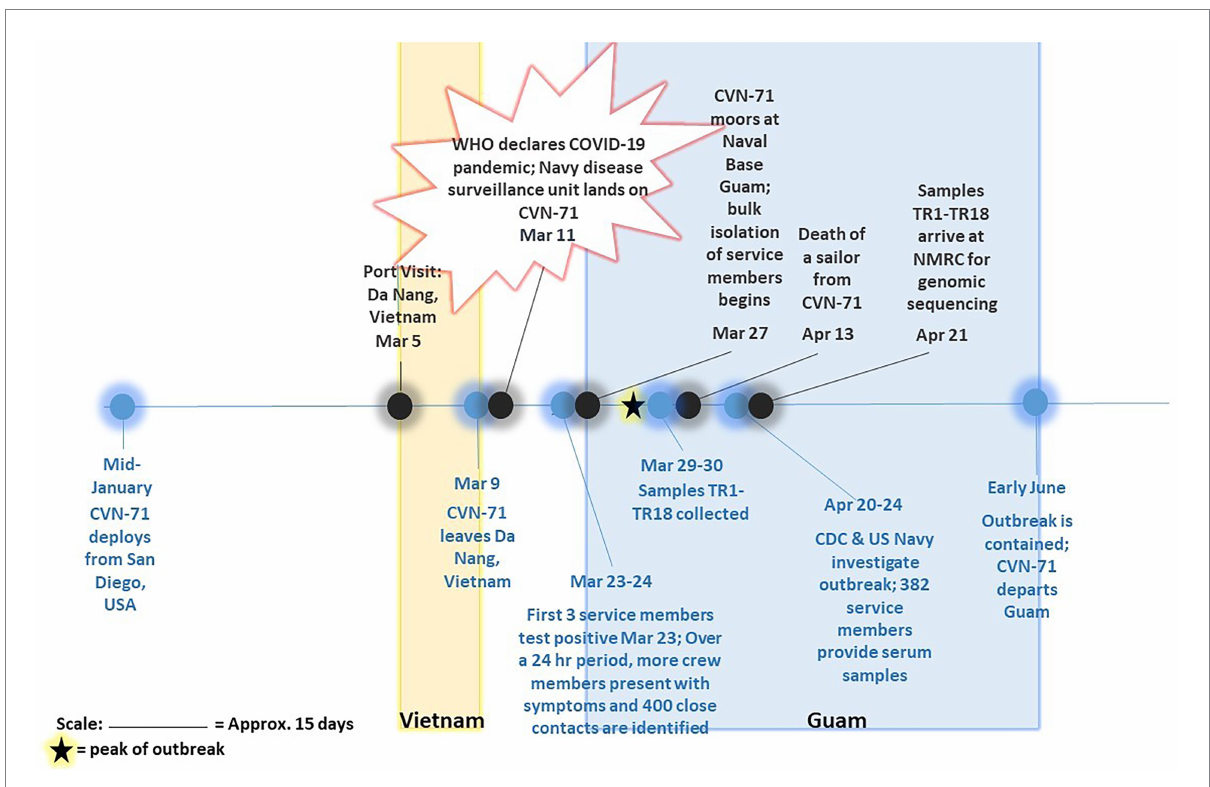
FIGURE 1 Timeline of COVID-19 outbreak on aircraft carrier USS Theodore Roosevelt in 2020. Major events pertaining to and surrounding outbreak of COVID-19 on CVN-71 as gathered from available references (Alvarado et al., 2020; Payne et al., 2020; Pike and Koblentz, 2020; Stewart and Ali, 2020; U.T.R.P. Affairs, 2020) are depicted, including collection of 18 samples of convenience for sequencing-based surveillance. The peak of outbreak as per Alvarado et al. (2020) is indicated on the timeline with a